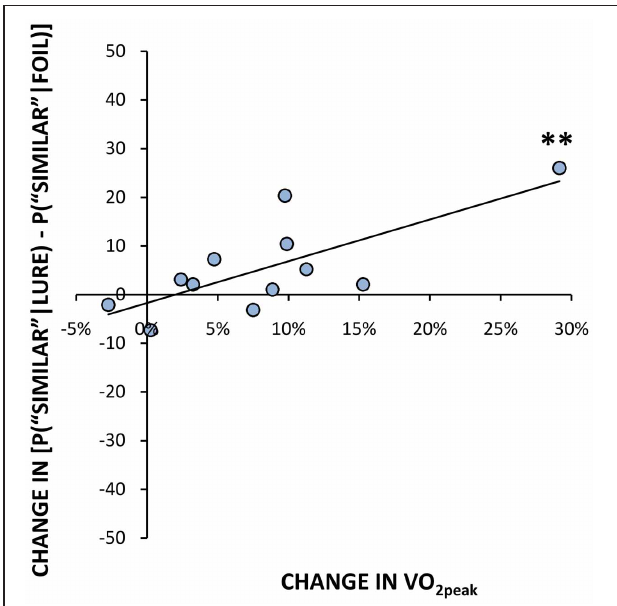
FIGURE 2 | Percent change in fitness scores (VO 2peak ) vs. change in mean % correct identification of lures as “similar” following exercise ( r = 0 . 74, p < 0 . 01). ∗∗ p ≤ 0 .